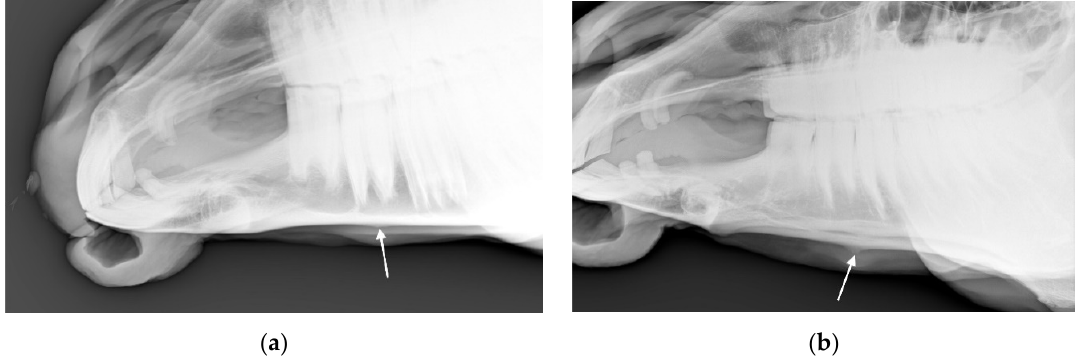
Figure 8. Radiograph showing the mandible of a horse in which radiologists ( n = 2) agreed there was bone deposition that was: ( a ) typical of affected horses and ( b ) moderate.